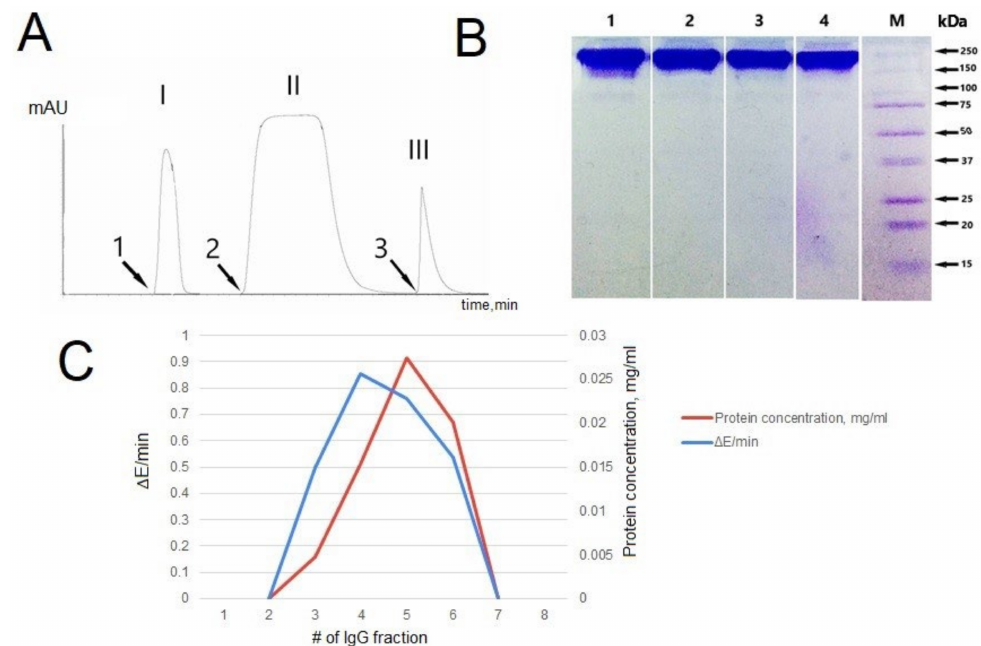
Figure 1. IgG purification and Application of Strict Criteria. ( A ) Profile affinity chromatography of IgGs isolated from the blood serum. 1—application of blood serum; 2—elution with buffer containing 1% Triton X-100 and 0.3 M NaCl; 3—elution with glycine–HCl buffer, pH 2.6. Peak I—proteins with no affinity for the sorbent; Peak II—lipids and non-specifically bound proteins; Peak III—immunoglobulin G. ( B ) Electrophoregram IgGs isolated from the blood serum after Coomassie G250 staining. M—protein molecular weight markers; 1–4—IgGs isolated from the blood serum. ( C ) Protein elution profile of gel filtration of IgGs in pH shock conditions (red line) and the change in the optical density of the solution per minute ( ∆ E/min) in the presence and in the absence of IgGs with SOD activity in the obtained fractions (blue